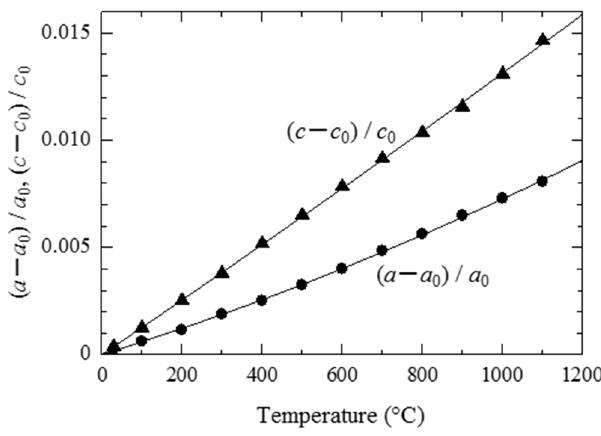
Figure 4. Temperature dependence of expansion ratio of a - and c -axes for SCAM crystal.